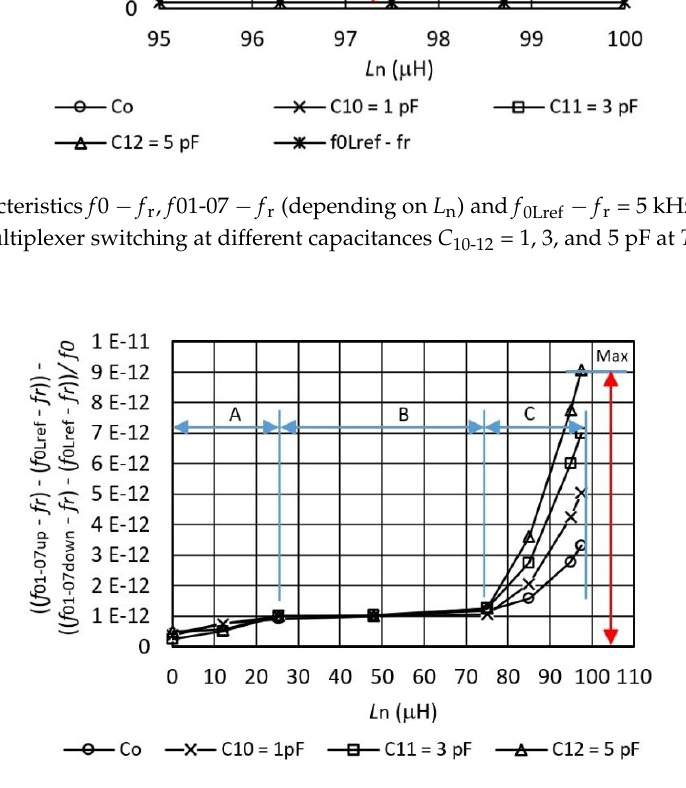
Figure 7. Hysteresis measurement error of the inductance-to-frequency converter depending on the L n = 0–99 µ H and capacitor value from C 10-12 = 1–5 pF, and switching frequency f switch = 1 Hz between L n and L ref .